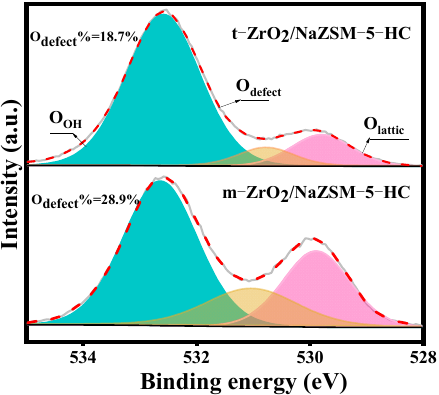
Figure 5. O 1s XPS spectra of t-ZrO 2 /NaZSM-5-HC and m-ZrO 2 /NaZSM-5-HC composite catalysts.